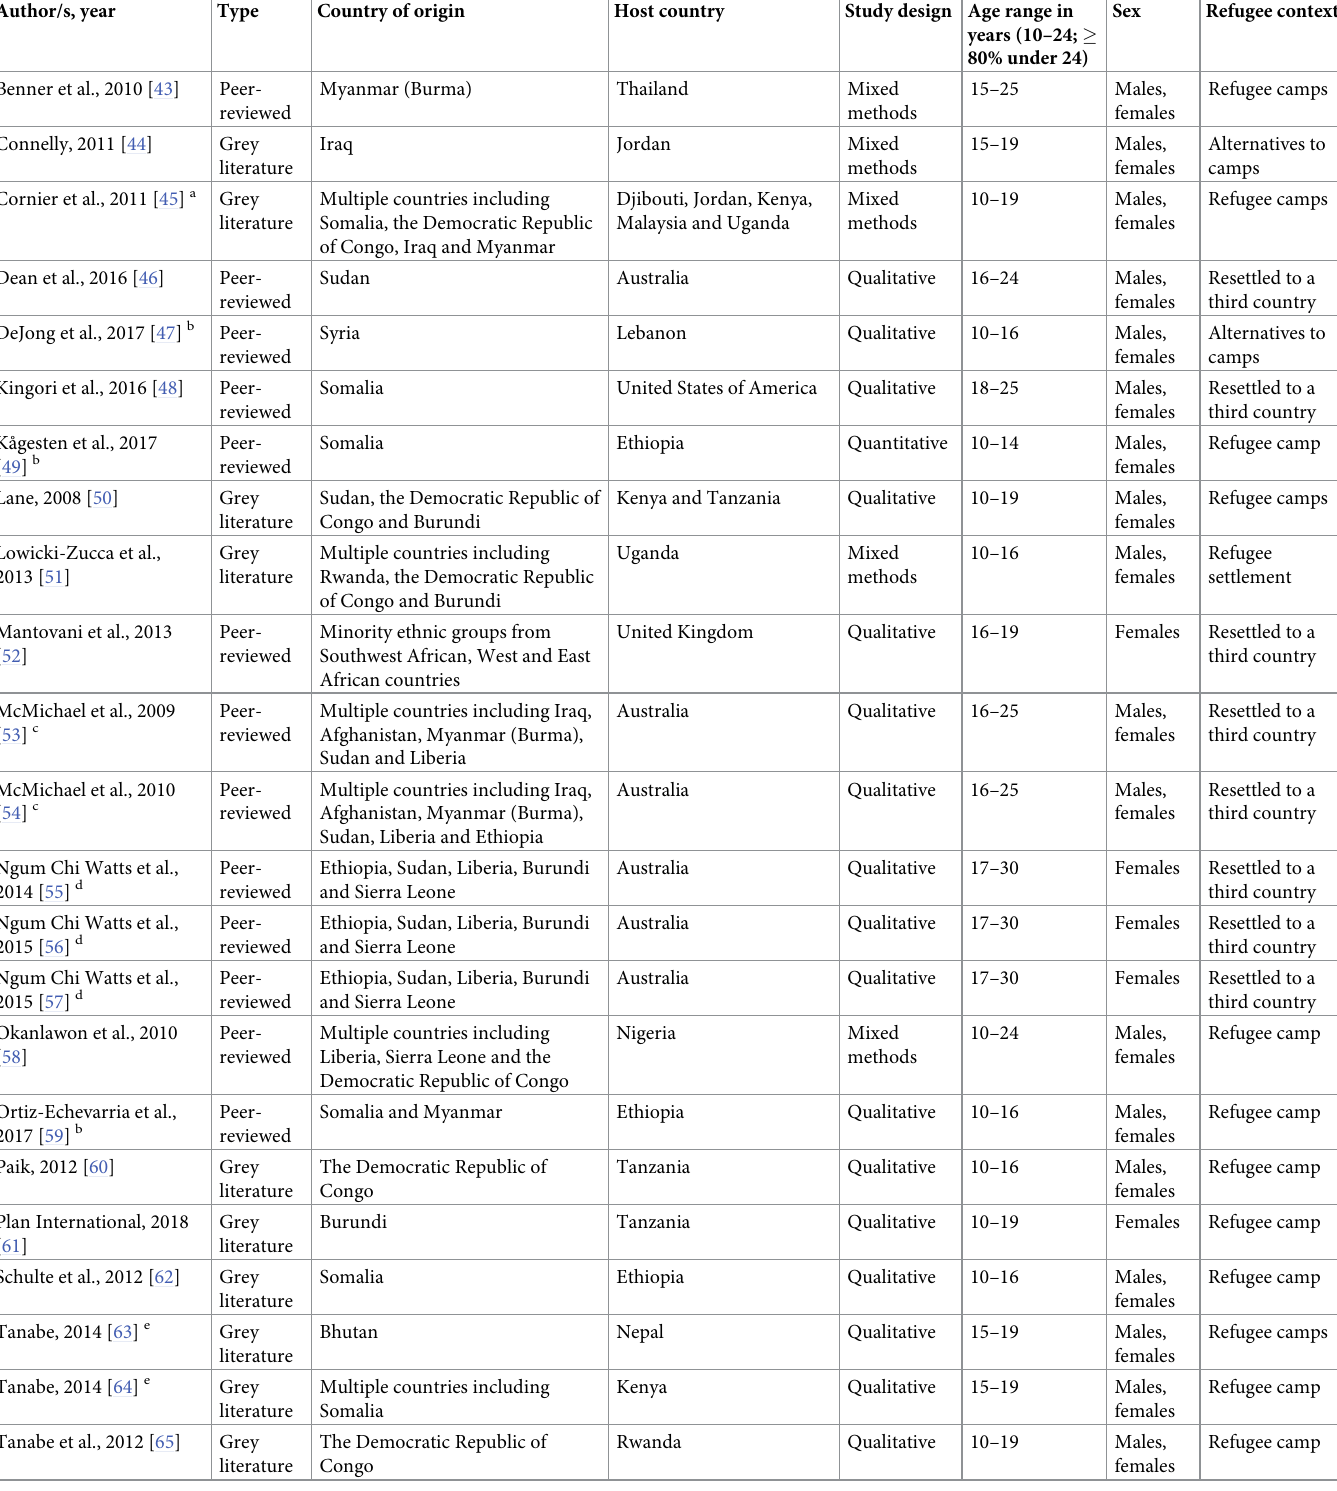
Table 1. Summary of the included